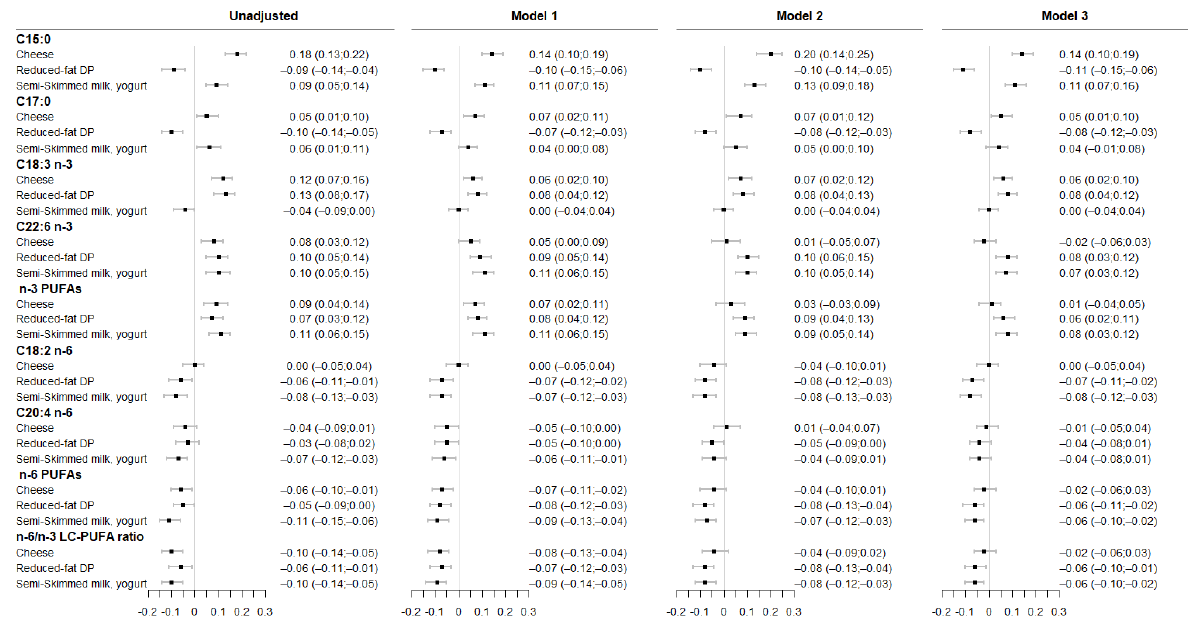
Figure 2. Associations between maternal DP patterns and fatty acid levels in maternal RBC membrane. Results are from linear regression models ( β (95%CI)). Model 1 was adjusted for study center and maternal age at delivery. Model 2 was adjusted for model 1 covariates and for maternal “healthy” dietary pattern during pregnancy. Model 3 was adjusted for model 1 covariates and for the frequency of fish consumption during pregnancy. All DP patterns were studied simultaneously within each model.